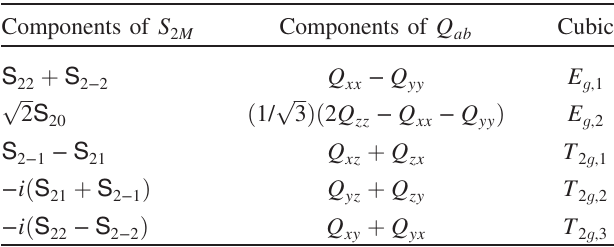
TABLE VI. Correspondence between the spin matrices S 2 and the components of the rank-2 tensor Q S 2 transform as a rank-2 tensor. S 3 M rank-3